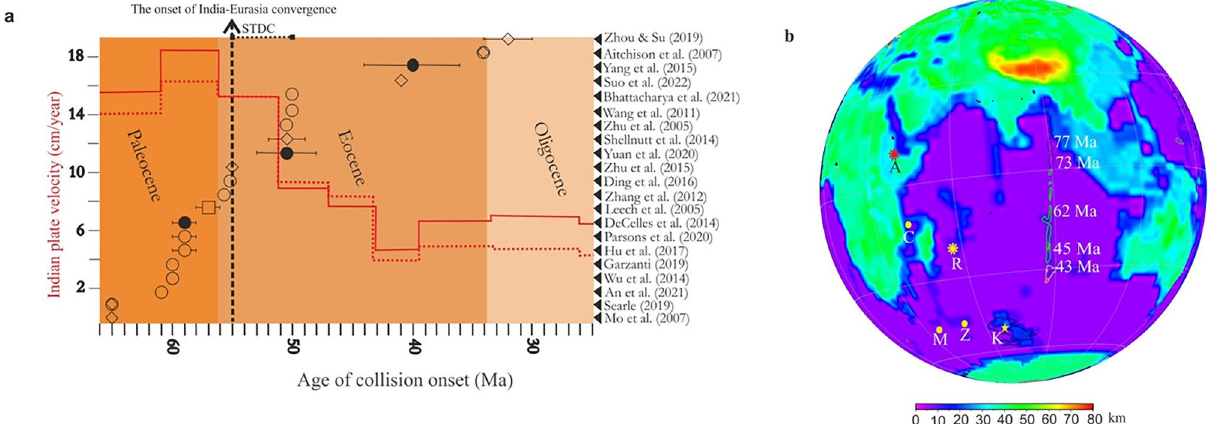
Figure 1. When did India–Eurasia collision start? ( a ) A broad spectrum of age possibilities 2–11,13,18,39–47 based on different geologic, kinematic, and stratigraphic evidence; the velocity curve of the Indian plate in red after van Hinsbergen et al. 48 . Open circles, stratigraphy/sedimentary/provenance estimation; open diamonds, tecto- magmatic ages; squares, metamorphic clue; solid circles, paleomagnetic/kinematic evidence. ( b ) Large igneous provinces of the Ninetyeast ridge related to the KMP assigned to their ages in white following the linear age propagation equation of Pringle et al. 49 , with thick crust in the Indian Ocean 50 . A Afar, C Comoros, K Kerguelen, M Marion, R Reunion, Z